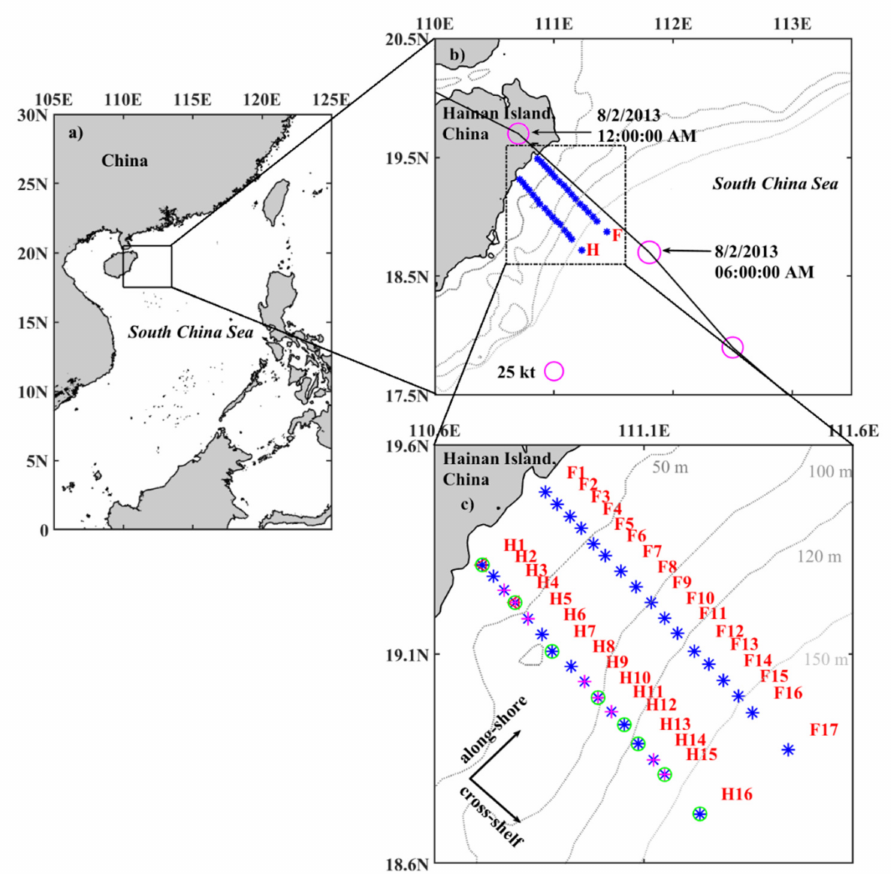
Figure 1. Map of the South China Sea ( a ), the study area with sections H and F (blue asterisks), and the ground path of the typhoon Chebi (2013) (black line with purple rings) ( b ). Purple rings represent the maximum wind speed of the typhoon. Cruise observation sections and stations are shown in panel ( c ), with station codes in red. Blue asterisks * represent the stations of the acoustic Doppler current profiler (ADCP). Pink pluses +, red triangles (cid:52) , and green circles with water sampling in the cases without the typhoon, before the typhoon, and after the typhoon in section H, respectively. Gray lines represent isobaths of 50, 100, 120, and 150